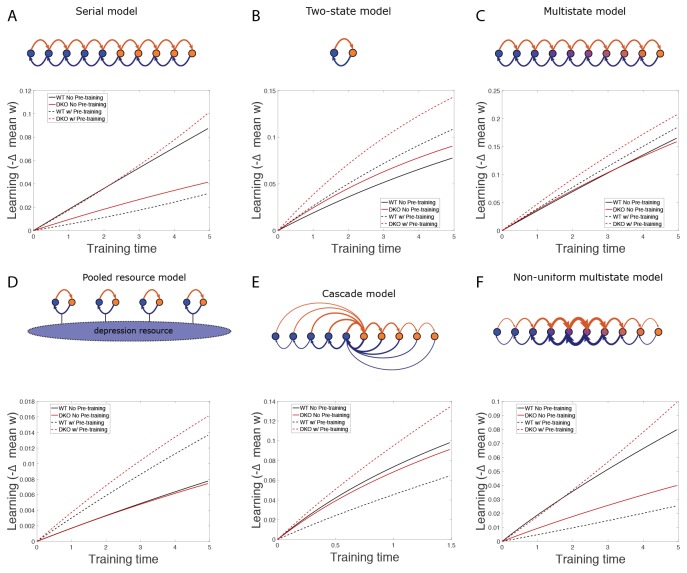
Simulation results.(A–F) Simulation results for various models, showing decrease in mean synaptic weight over time during gain increase training from the normal state (solid) and after gain-decrease pre-training (dashed) for wild-type (WT; black) and DKO (red) models.